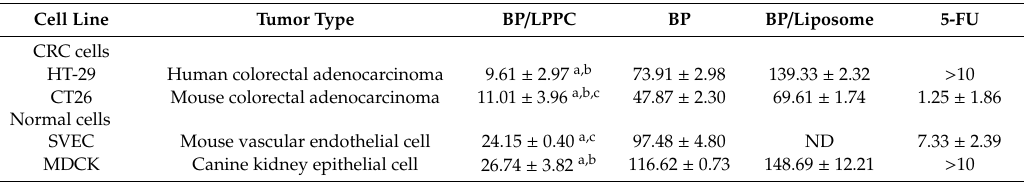
Table 1. IC 50 values of BP / LPPC against di ff erent colorectal cancer